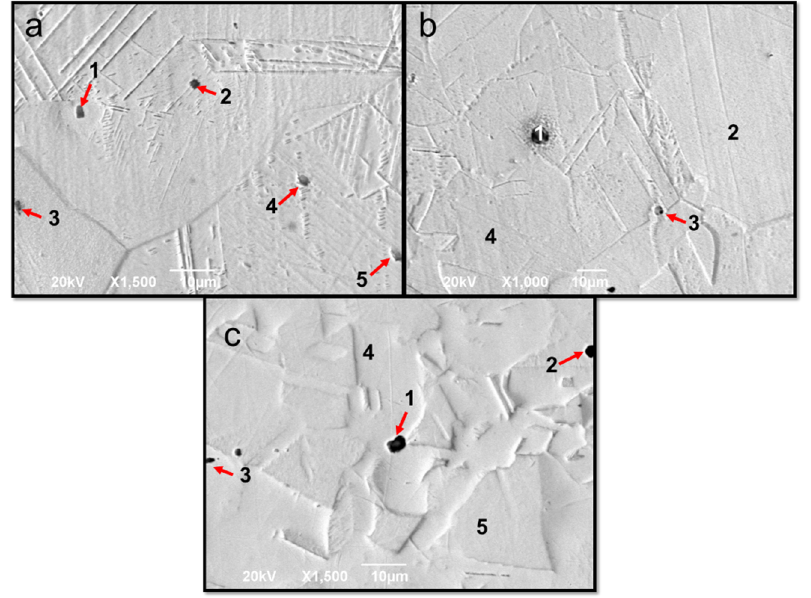
Figure 4. SEM images of the microstructures of the ( a ) 0Al; ( b ) 3Al; ( c ) 8Al alloys. The numbers correspond to the spectrum showed in Table 3. Table 3. EDS composition (wt.%) corresponding to the surfaces of the alloys shown in Figure 4.